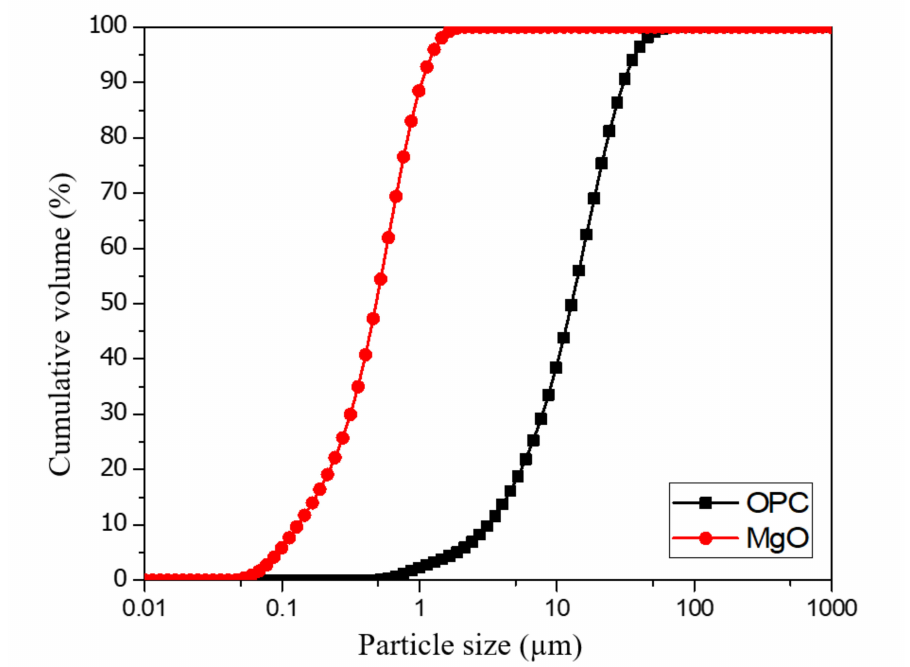
Figure 1. Particle size distributions of Ordinary Portland Cement (OPC) and magnesium ox- ide (MgO).